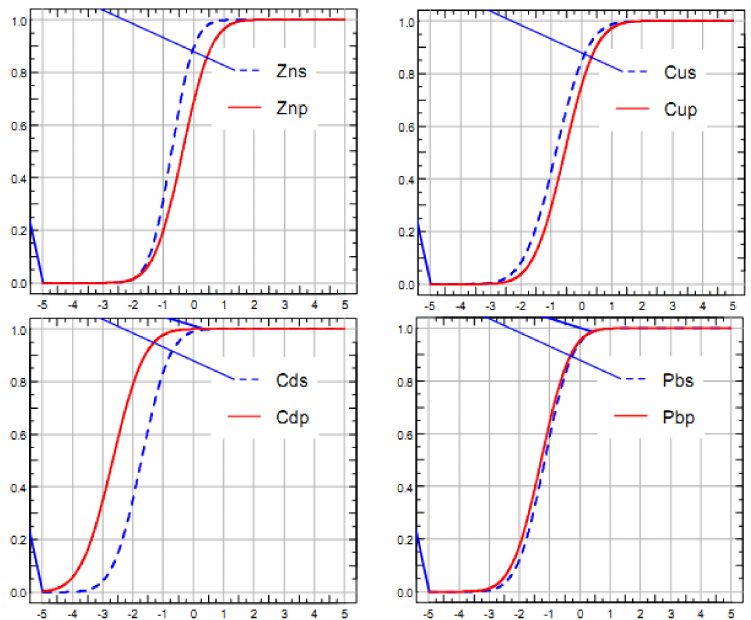
Figure 3. The curve of accumulation probability of the element hazard quotient.